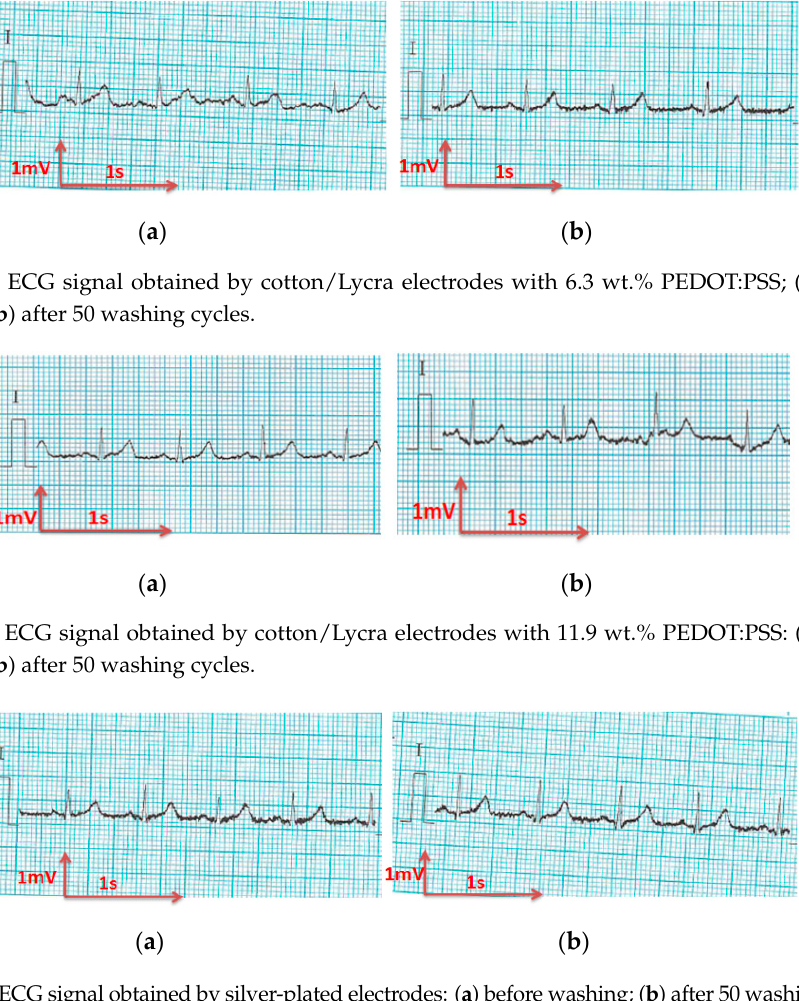
Figure 14. ECG signal obtained by silver-plated electrodes: ( a ) before washing; ( b ) after 50 washing cycles.